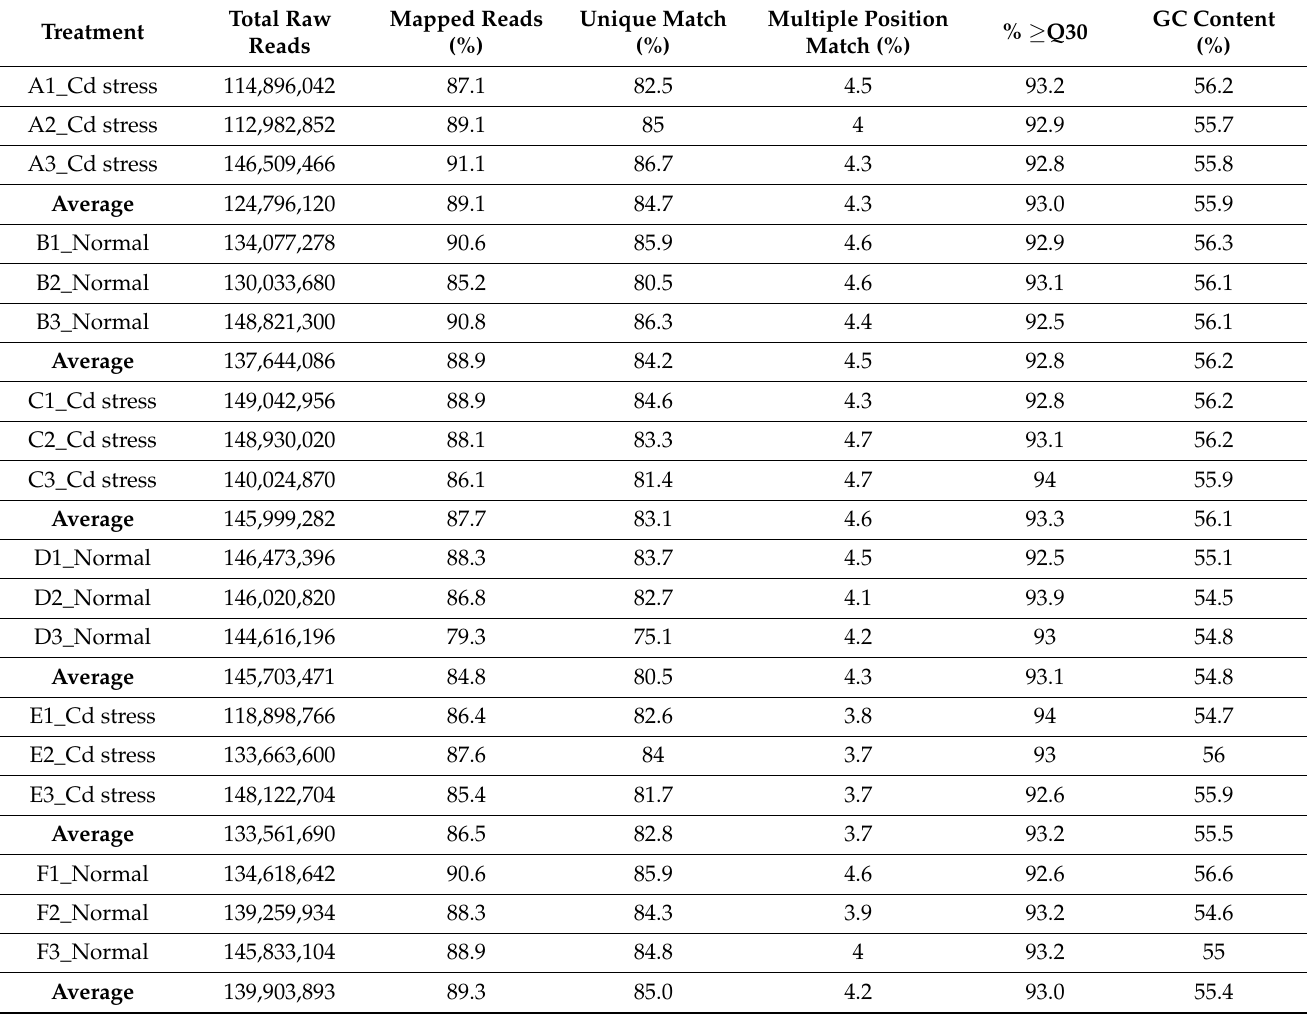
Table 1. Summary of total and clean reads from 18 comparative libraries.